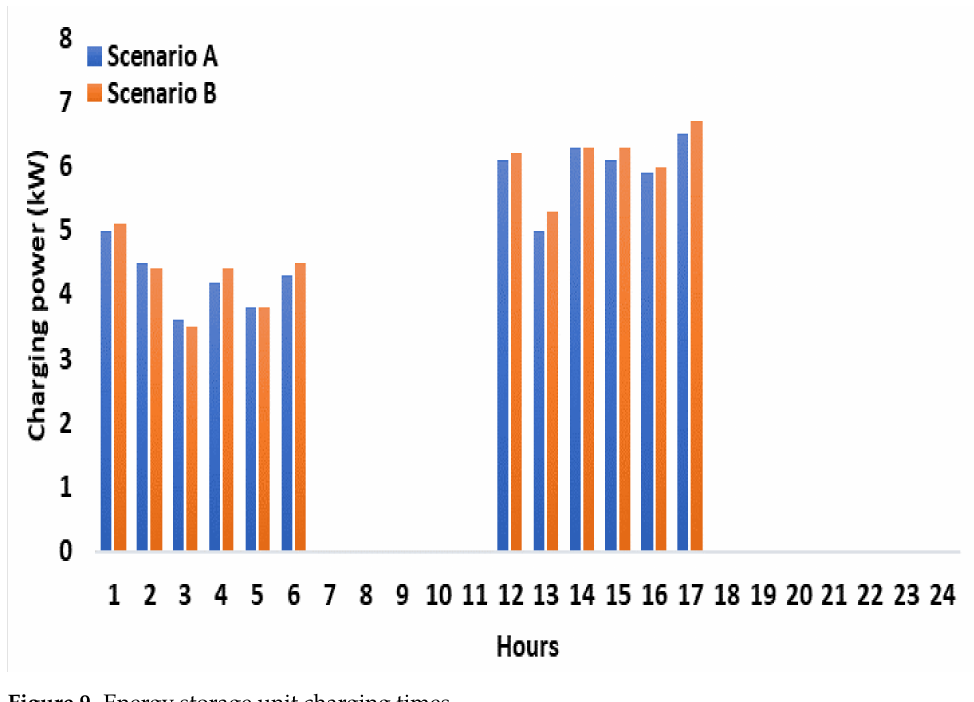
Figure 9. Energy storage unit charging times.